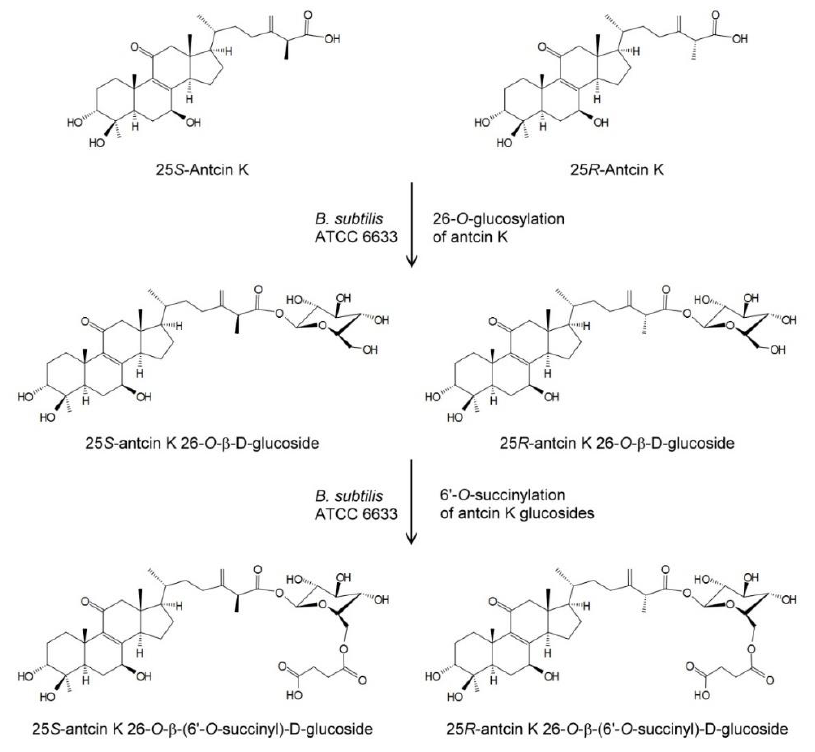
Figure 4. Biotransformation process of antcin K by the B. subtilis ATCC 6633 strain.